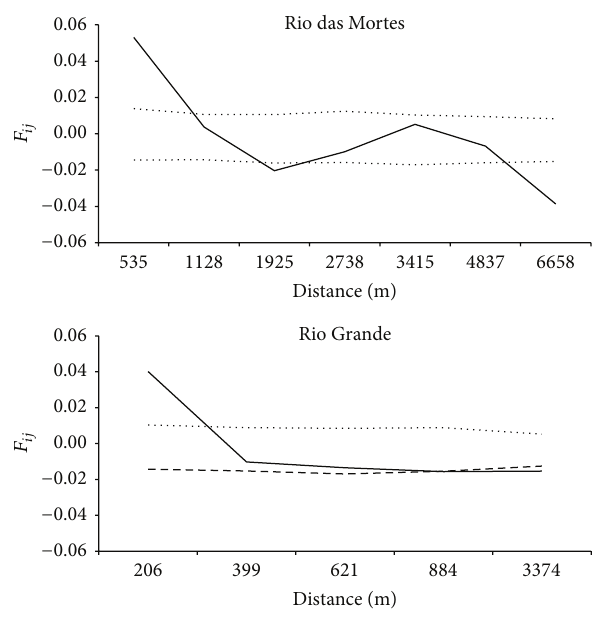
Figure 4: Correlograms of average coancestry coefficients ( 𝐹 𝑖𝑗 ) per distance class in two Calophyllum brasiliense populations. Confidence intervals around each 𝐹 𝑖𝑗 -value were obtained using a jackknife procedure across all